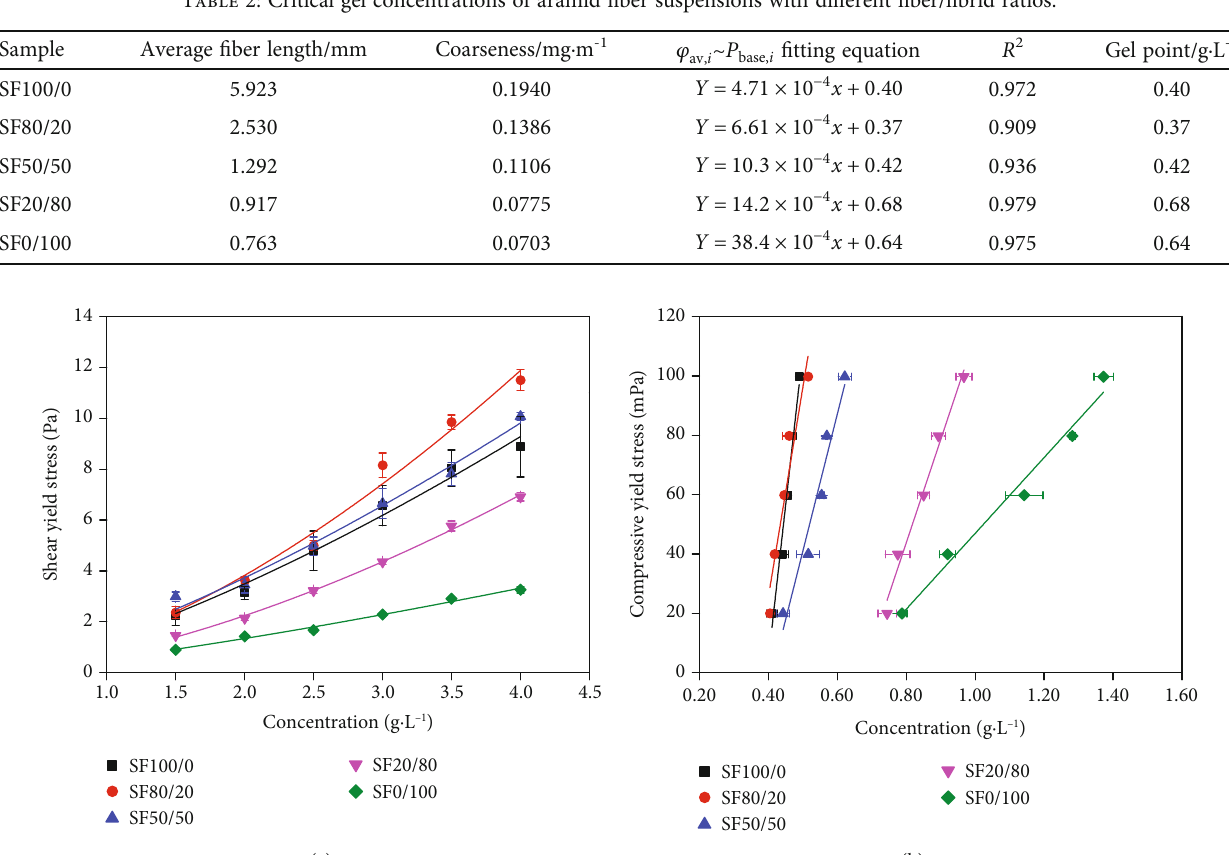
Table 2: Critical gel concentrations of aramid fi ber suspensions with di ff erent fi ber/ fi brid ratios.